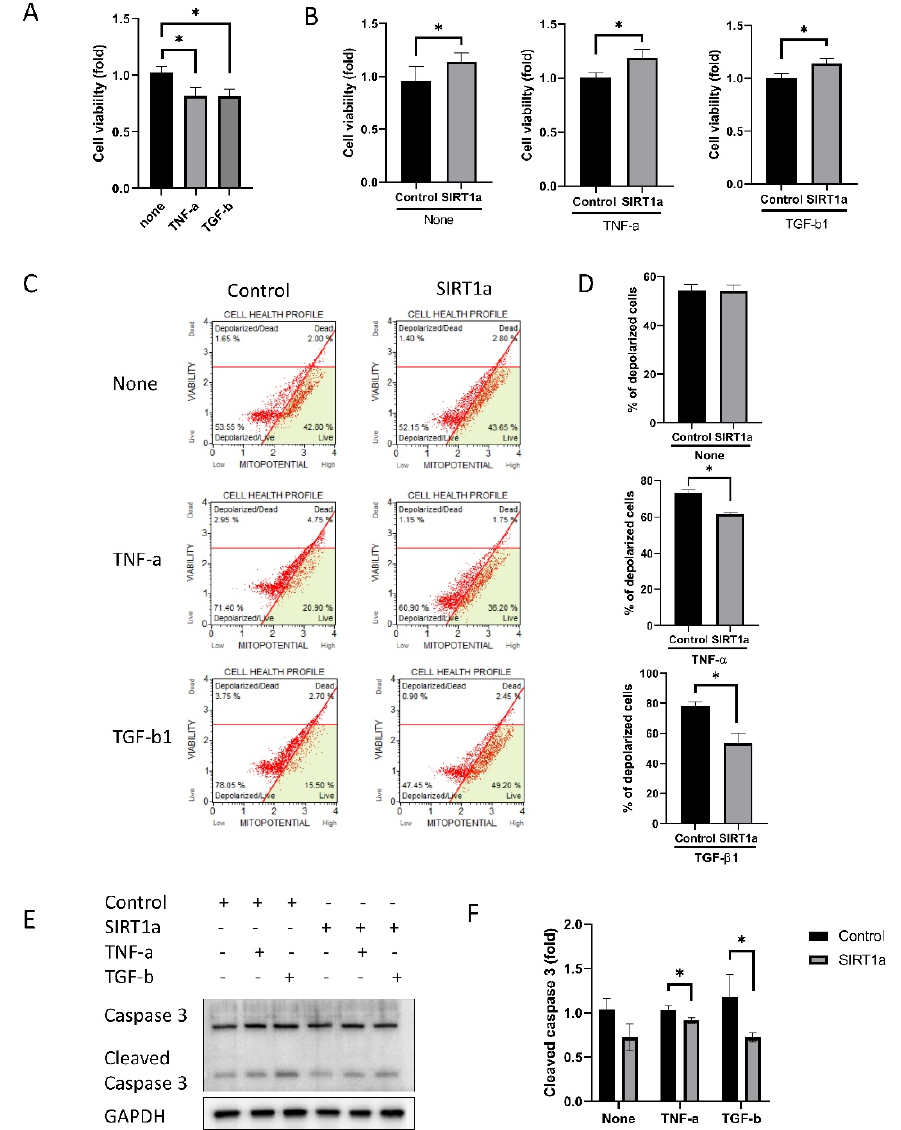
Figure 5. SIRT1 inhibits cytokine-induced cell death. ( A ) Cells were treated with tumor necrosis factor-alpha (TNF-α) and transforming growth factor-beta1 (TGF-β1). Cell viability was reduced when treated with TNF-α or TGF-β1. ( B ) Cell viability was increased in SIRT1a group compared to control in untreated or upon treatment with either TNF-α or TGF-β1. ( C , D ) Mitochondrial membrane potential was depolarized upon TNF-α or TGF-β1 treatment. The number of depolarized cells was increased in SIRT1a group compared to control upon treatment with TNF-α or TGF-β1. ( E , F ) Cleaved caspase 3 level was decreased in SIRT1a group compared to control upon treatment with TNF-α or TGF-β1. All experiments were performed in triplicate or quadruplicate * for p < 0.05 using independent t